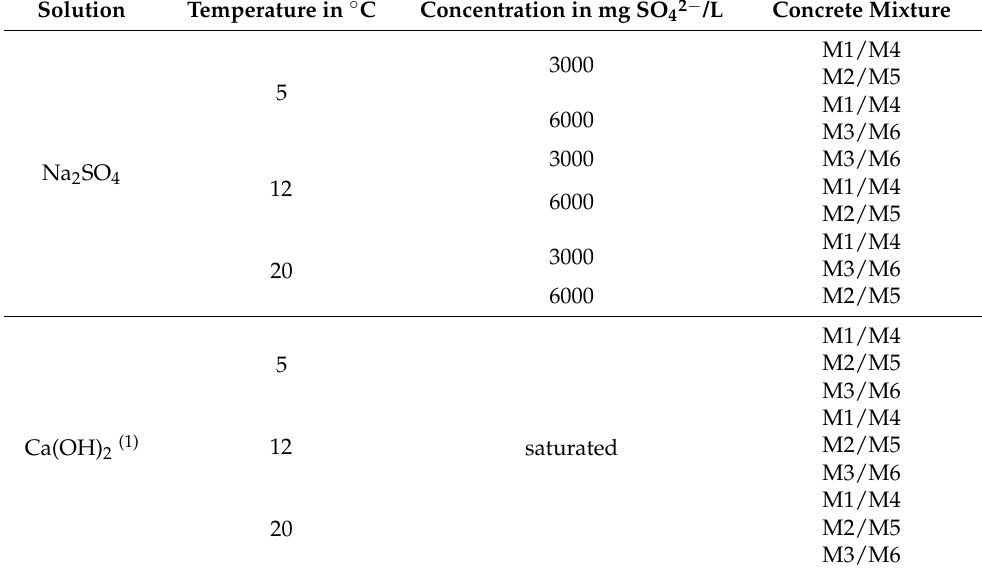
Table 5. Factorial design of